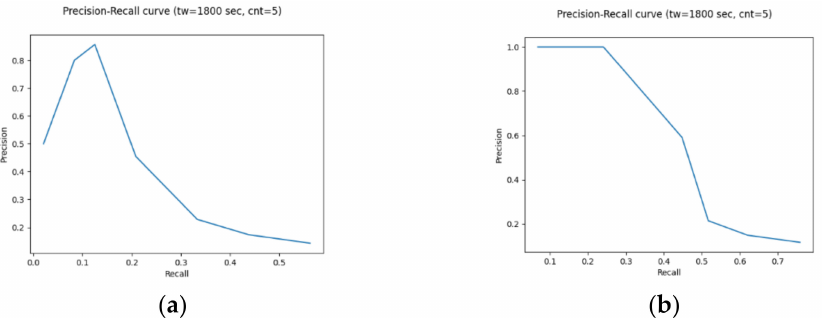
Figure 7. Precision–Recall curve keeping the window at 1800 s and the count threshold at 5 while increasing the similarity threshold from 0.55 to 1.0 with a step of 0.5: ( a ) three-vote unanimous set; ( b ) two-vote majority set.